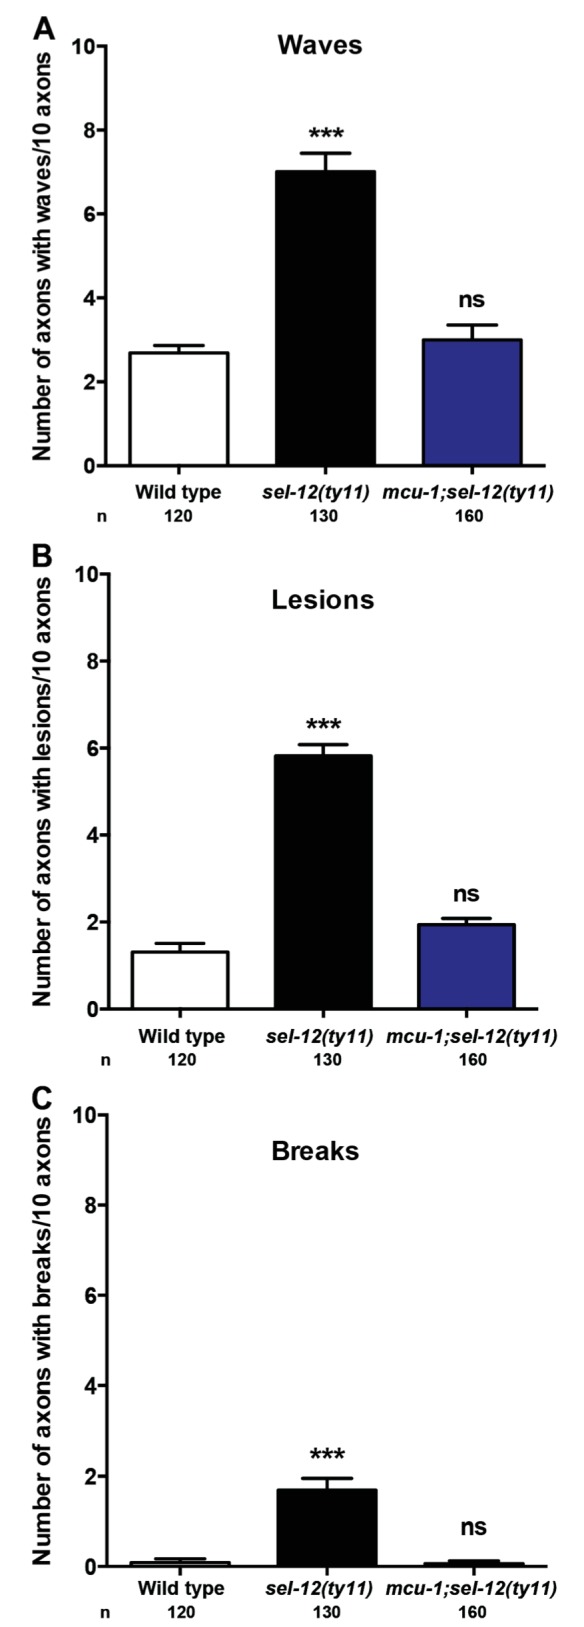
Reduction of ER Ca2+ release improves the structure of mechanosensory neurons in sel-12 animals.Quantification of (A) wavelike processes, (B) lesions and (C) breaks in ALM and PLM neuronal processes in wild type, sel-12(ty11) and mcu-1;sel-12(ty11) animals at day 1 of adulthood. Neuronal morphology analysis is done using transgenic animals expressing mec-4p::GFP (zdIs5). n = number of animals analyzed per genotype. Data are displayed as mean ± SEM, and all comparisons have been made to wild type animals unless otherwise indicated. ns p>0.05, ***p<0.0001 (One way ANOVA with Tukey).10.7554/eLife.33052.030Figure 7—figure supplement 1—source data 1.Raw data for Figure 7—figure supplement 1.